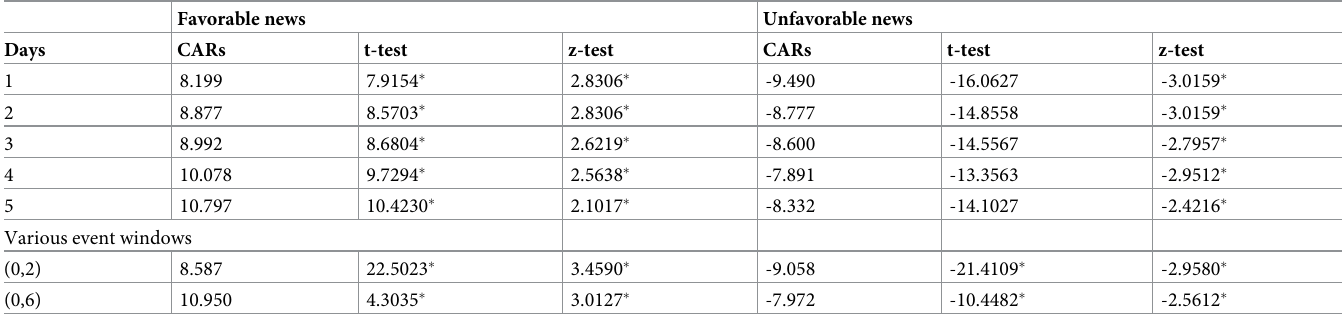
Table 7. Post-event CARs for the COVID19 sub-period (11.03.2020–12.08.2021)–favorable and unfavorable